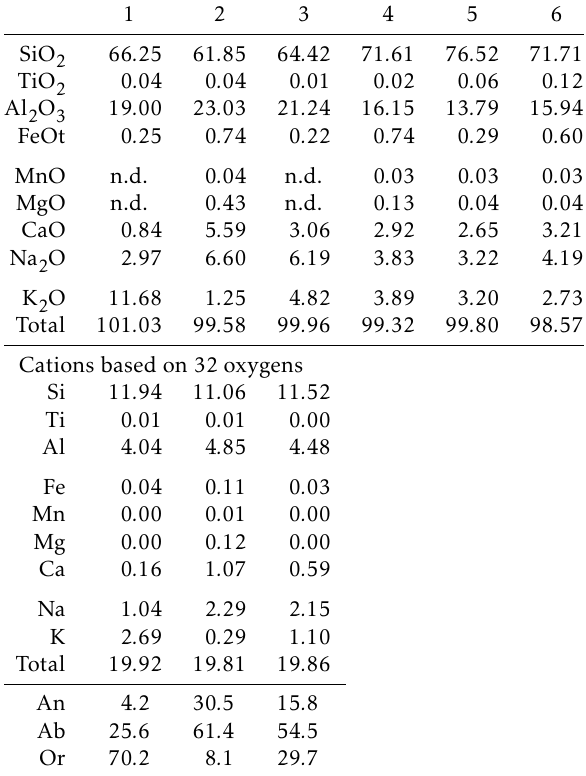
a dacitic composition by Green